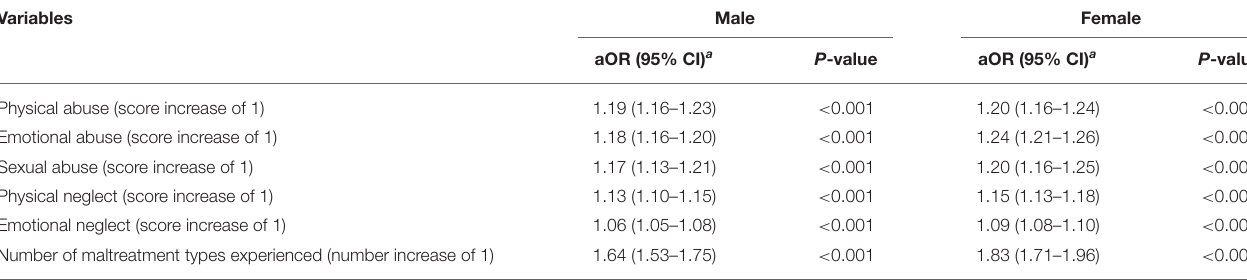
TABLE 5 | Associations between child maltreatment and depressive symptoms, stratified by sex.